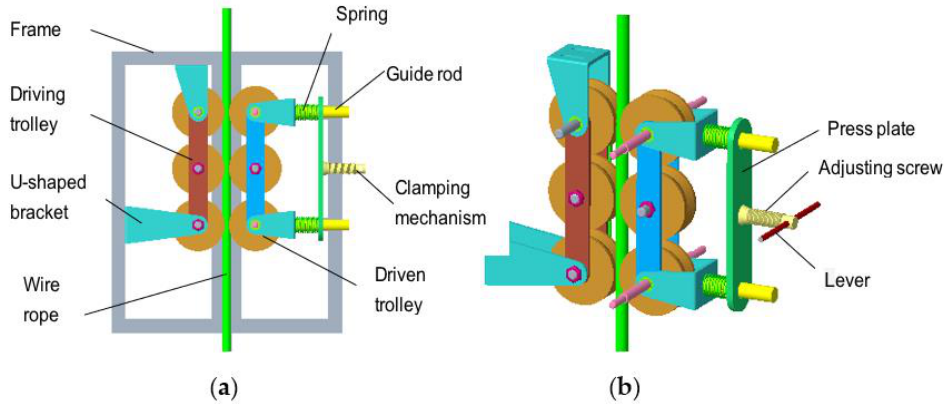
Figure 3. The 3D CAD structure of the attachment device. ( a ) The external frame of the attachment device, and ( b ) the internal structure of the attachment device.